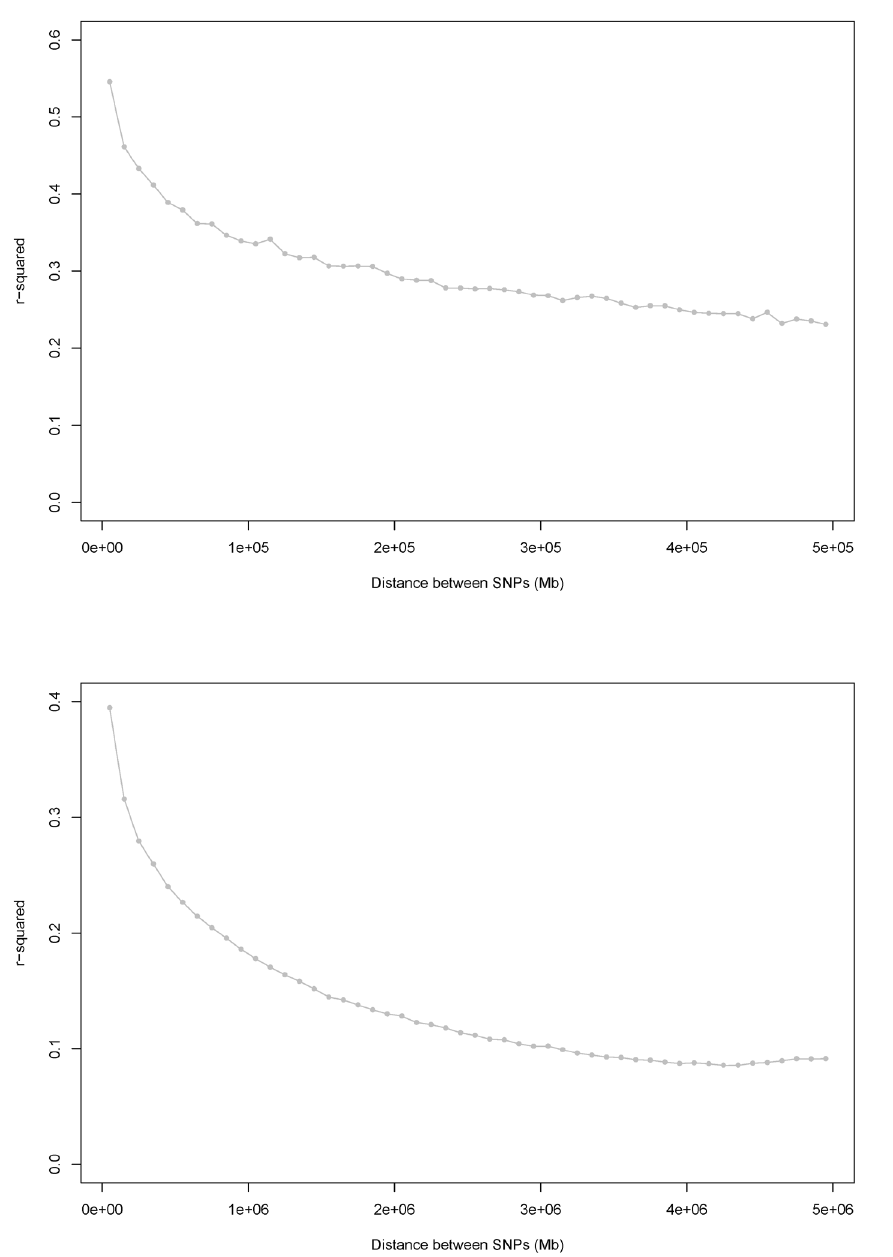
Figure 2. Average LD vs the median of the distance bin range (Mb). (a) Distances ranged from 0 to 0.5 Mb (bin distance range: 0.01 Mb). r 2 values were averaged using bins of 0.01 Mb and pooled over autosomes. (b) Distances ranged from 0 to 5 Mb (bin distance range: 0.1 Mb). r 2 values were averaged using bins of 0.1 Mb and pooled over